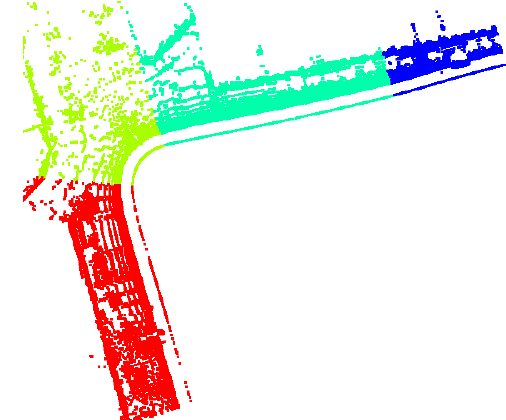
Figure 3: Result of polygonal segmentation and the associated partition of the lidar point cloud over an area of interest (one color per segment, top view). One can note that all the segments do not have the same